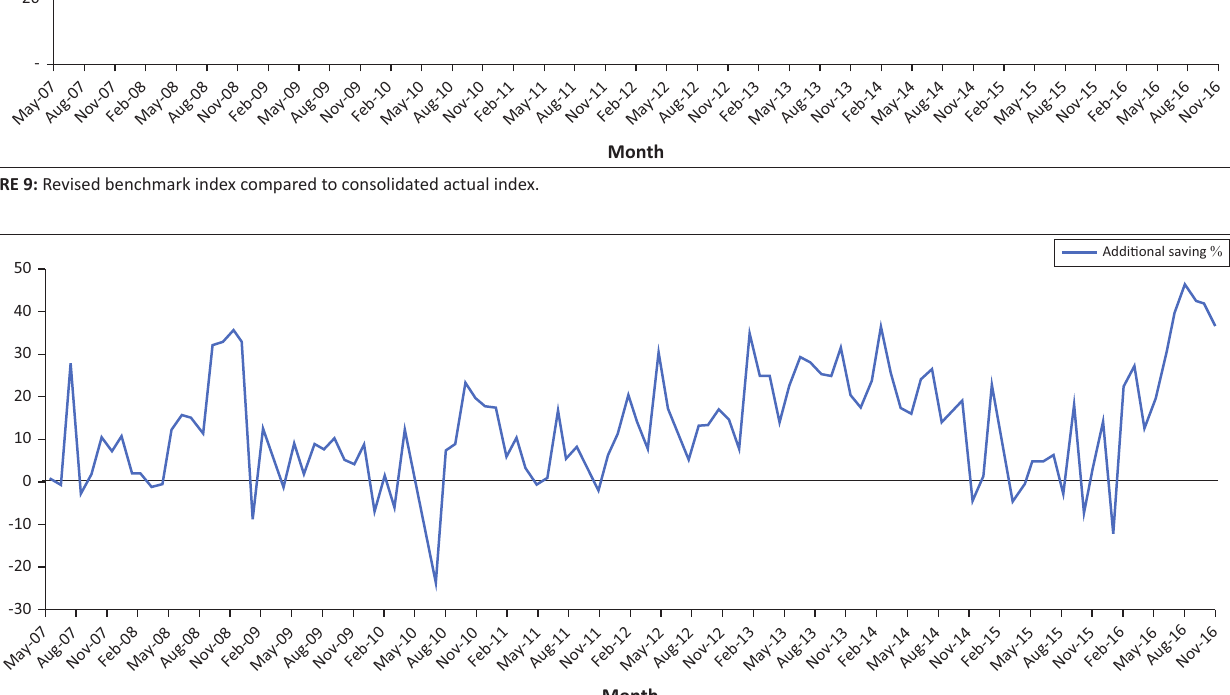
FIGURE 10: Additional